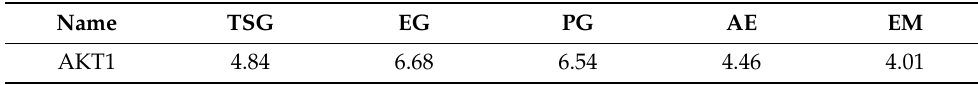
Figure 6. Visualization of the binding of hemostatic components to coagulation target protein (AKT1). Table 6. Score of molecular docking.